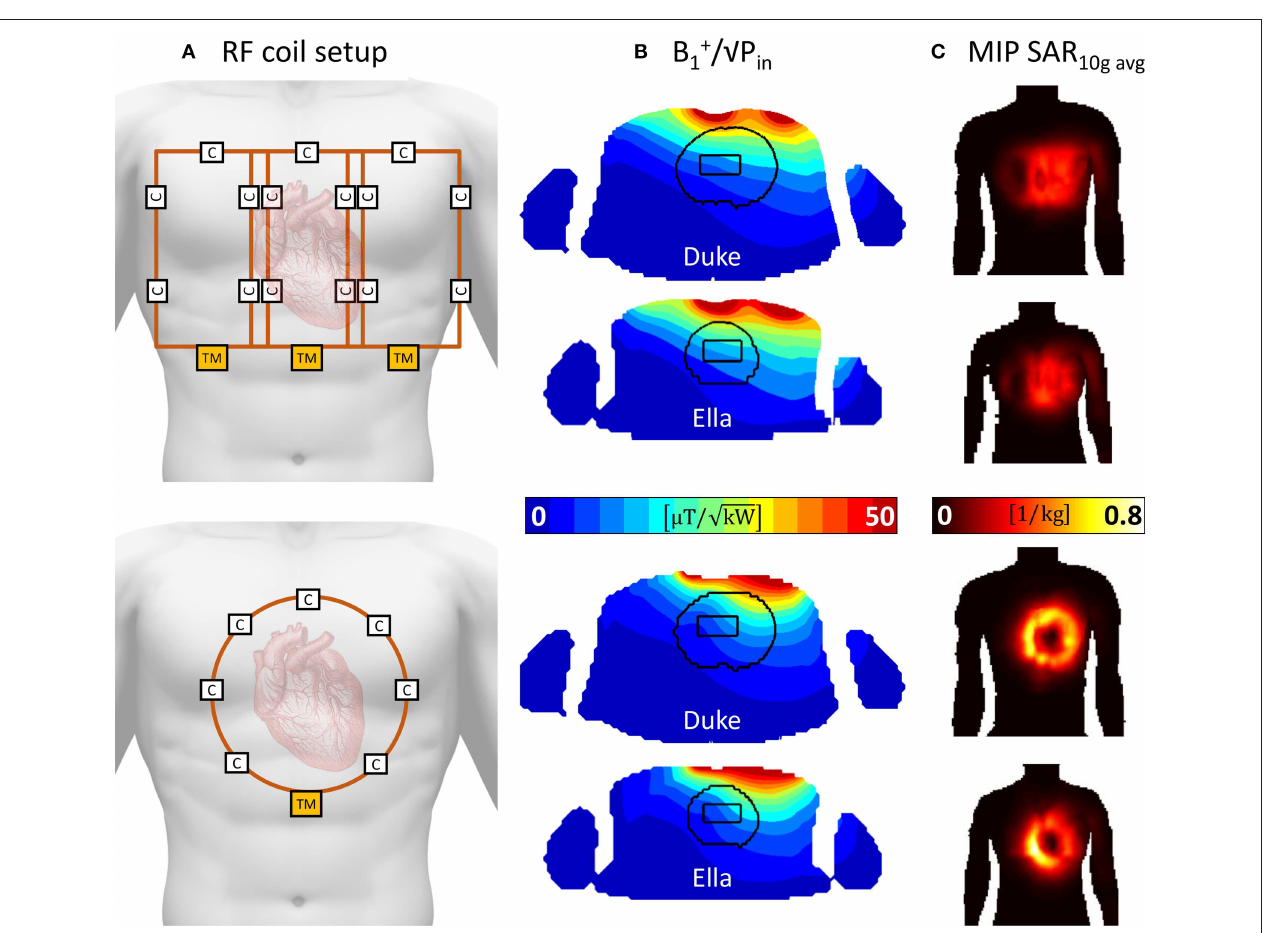
FIGURE 4 | Simulation comparison of the proposed 3-element array with a standard 14cm single loop coil. (A) depicts the RF coil setups, the proposed array is depicted in the top row, whereas the single loop is depicted in the bottom part. Both coils are positioned centered over the heart. (B) shows the resulting B + 1 / √ P in maps in a transversal slice through the center of the heart ROI. Higher B + 1 values are seen for the 3-element arrays. (C) depicts coronal maximum intensity projections of the 10g averaged specific absorption rate (SAR).